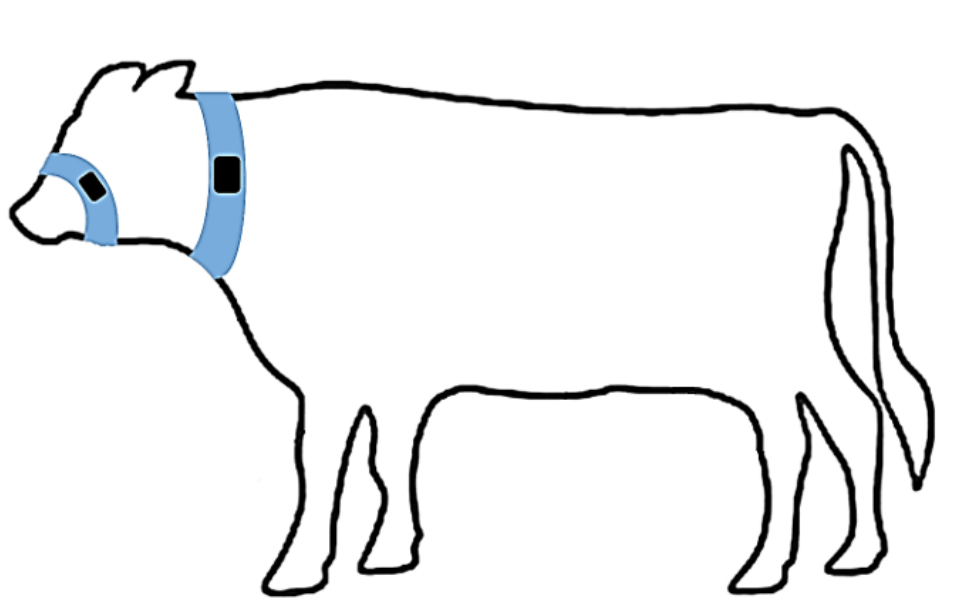
Figure 2. Placement of Rumiwatch halter on steer muzzle, Afimilk Silent Herdsman collar around animal’s neck.